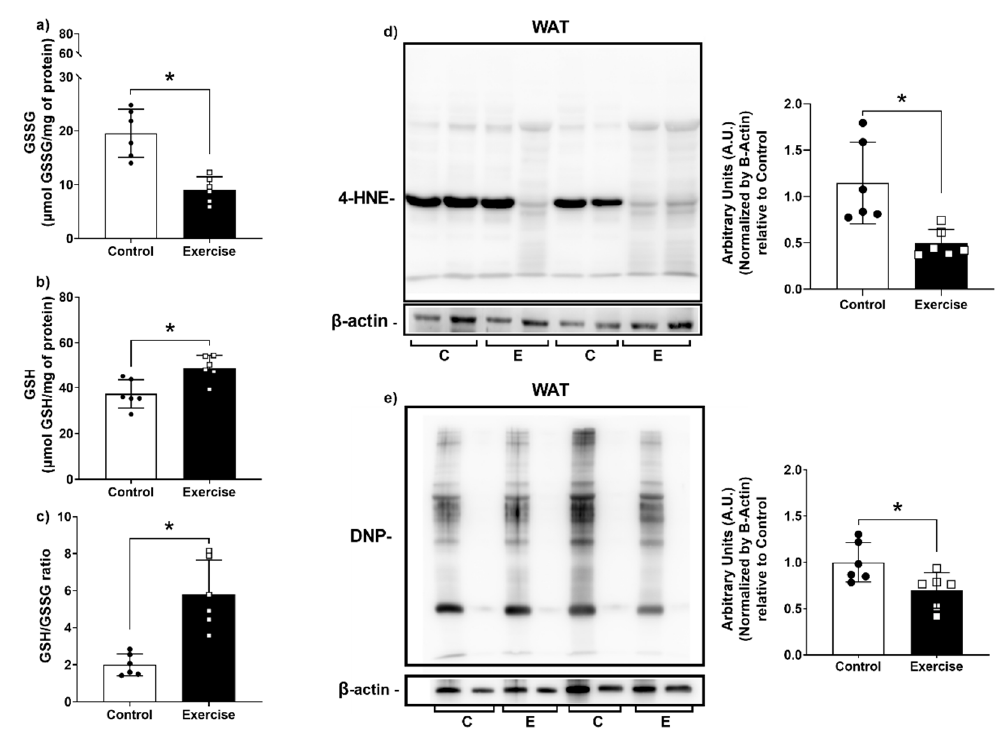
Figure 6. Aerobic exercise reduced oxidative damage markers in WAT. ( a ) Content of GSSG; ( b ) Content of GSH; ( c ) GSH/GSSG ratio; ( d ) Levels of lipid peroxidation; ( e ) Levels of carbonylated proteins. GSSG: Glutathione disulfide (oxidized); GSH: Reduced Glutathione; 4-HNE: 4-Hydroxynonenal; DNP: 2,4-Dinitrophenyl. The data were expressed as the mean ± standard error of the mean. ( n = 6 animals/group). • -Control group; ▫ –Exercise group. * Statistical difference between groups.